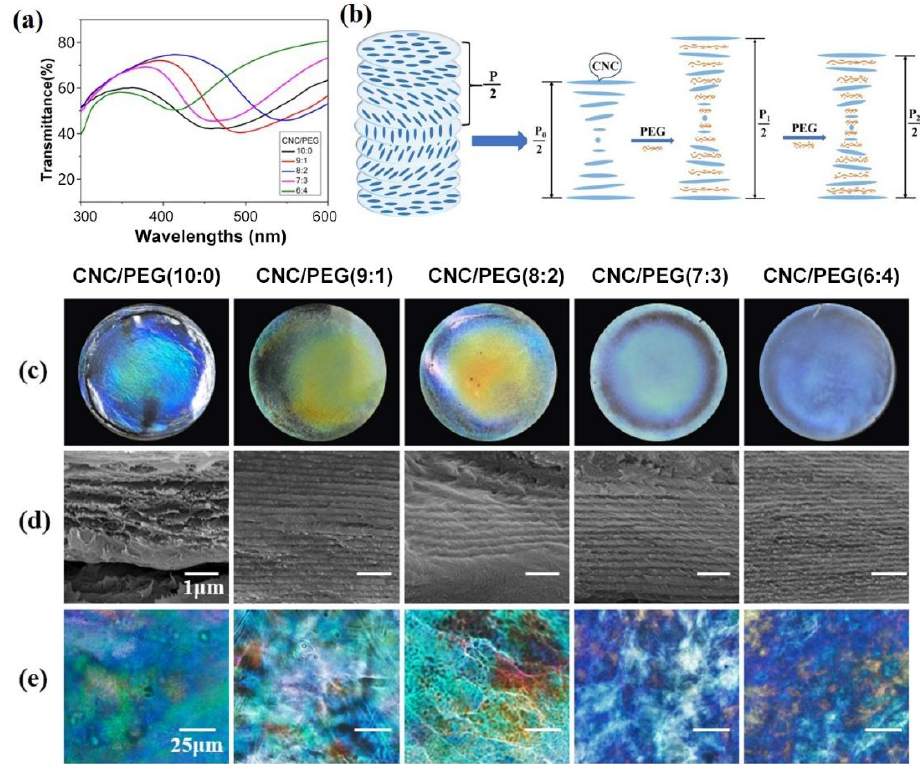
Figure 4. ( a ) Transmission spectra of CNC-PEG composite films; ( b ) schematic diagram of the effect of the introduction of PEG on the pitch of the CNC-PEG composite films with a chiral nematic structure. The addition of PEG causes the pitch to increase and then decrease; ( c ) photographs of the CNC-PEG composite films under natural light; ( d ) corresponding cross-sectional SEM images of the CNC-PEG composite films; ( e ) POM images of the CNC-PEG composite films.